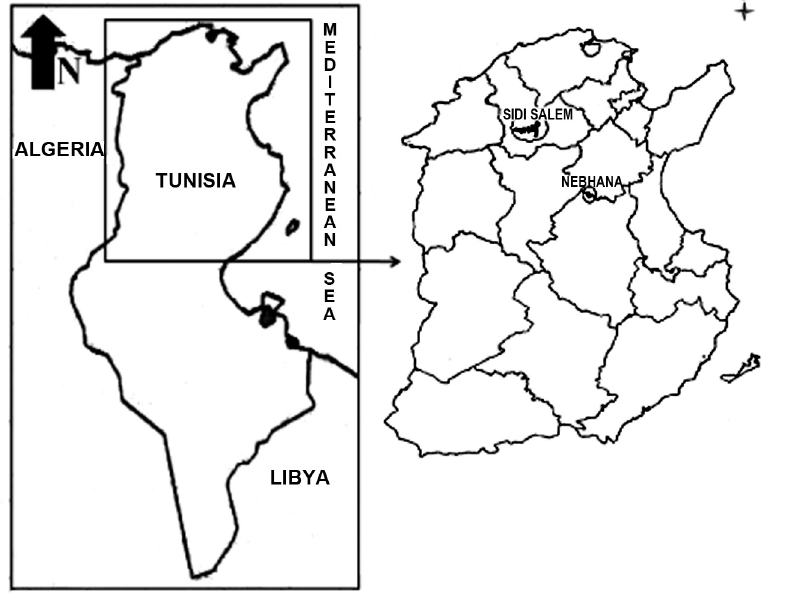
Fig 1. – Sites d’échantillonnage du gardon, Rutilus rubilio et du rotengle, Scardinius erythrophthalmus .